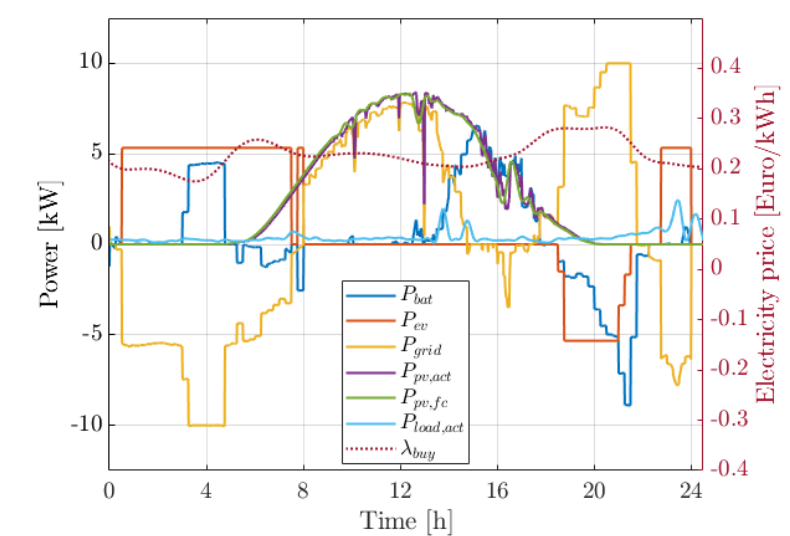
Figure 16. Comparison of the same day without power